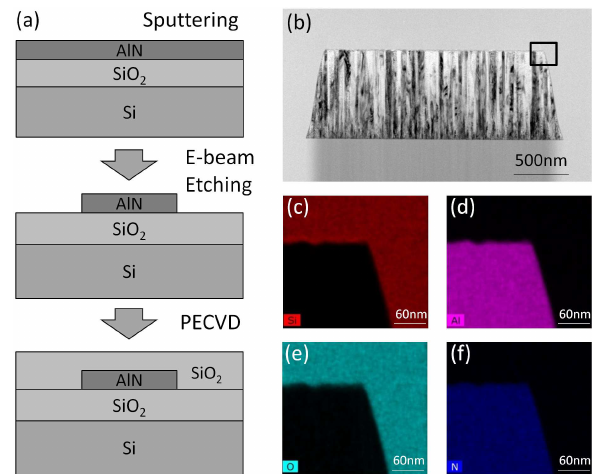
Figure 1: (a) Fabrication process flow of AlN micro-ring waveguide. (b) Cross section TEM image of the AlN waveguide with EDX map- ping of (c) Si, (d) Al, (e) O and (f) N. AlN: aluminum nitride; TEM: transmission electron microscopy; EDX: energy dispersive X-ray spectroscopy.